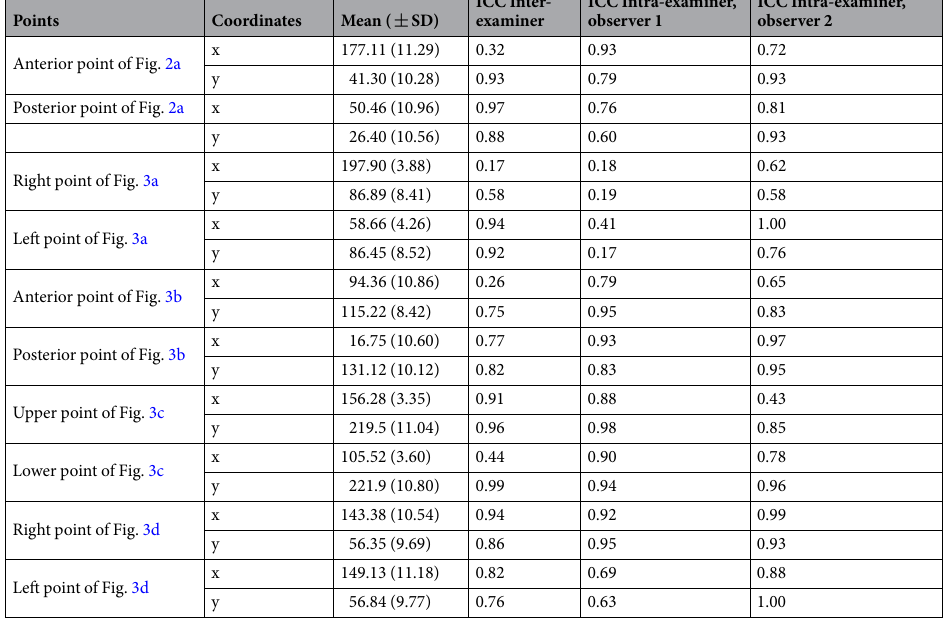
Table 2. Coordinates and intraclass correlation coefficients of 10 points used in this study. ICC; intraclass correlation